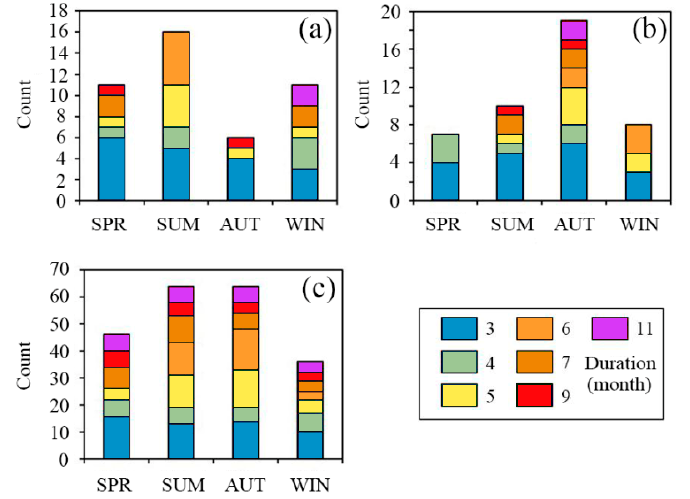
Figure 4. Cumulative histograms for occurrence time ( a ), ending time ( b ), and duration ( c ) of drought events in southern Tibet.